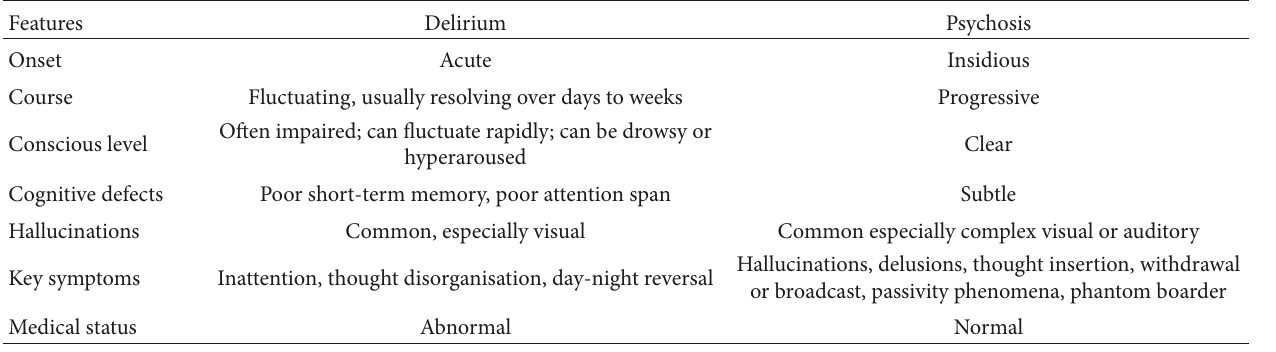
Table 3: Features of delirium versus psychosis in